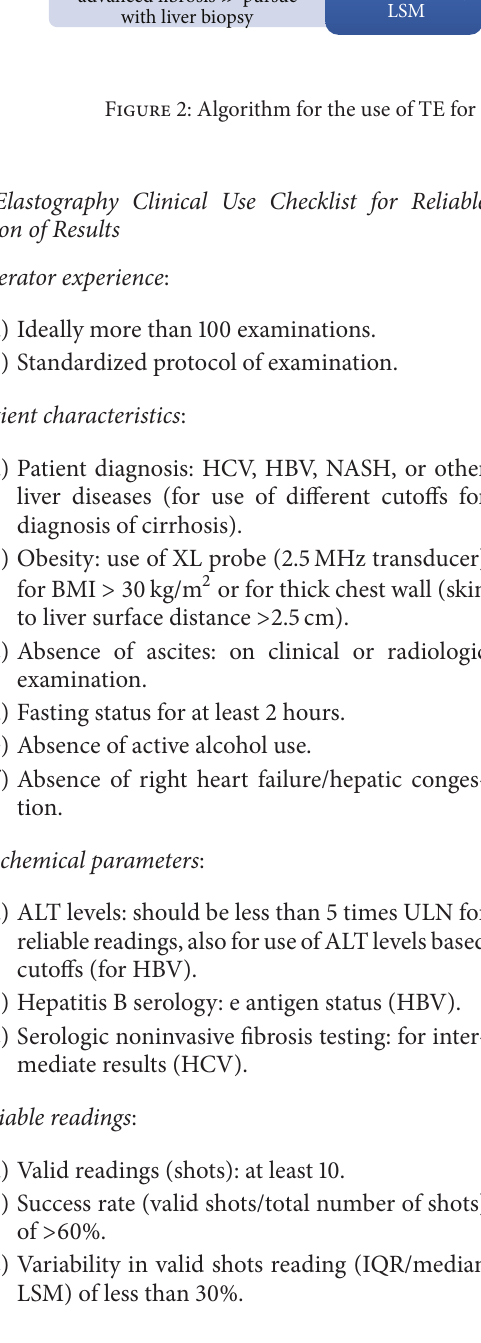
Figure 2: Algorithm for the use of TE for liver staging in HCV and HIV-HCV coinfection.